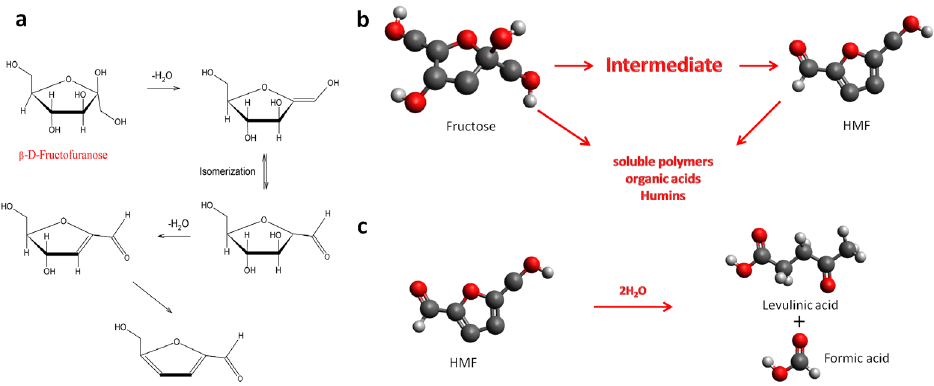
Figure 1. Typical contour map obtained for the HMF produced from the fructose dehydration reaction. ( a ) The left panel represents a standard solution of HMF (0.92 mg mL −1 ), whereas ( b ) the right panel corresponds to a sample from the reaction with niobic